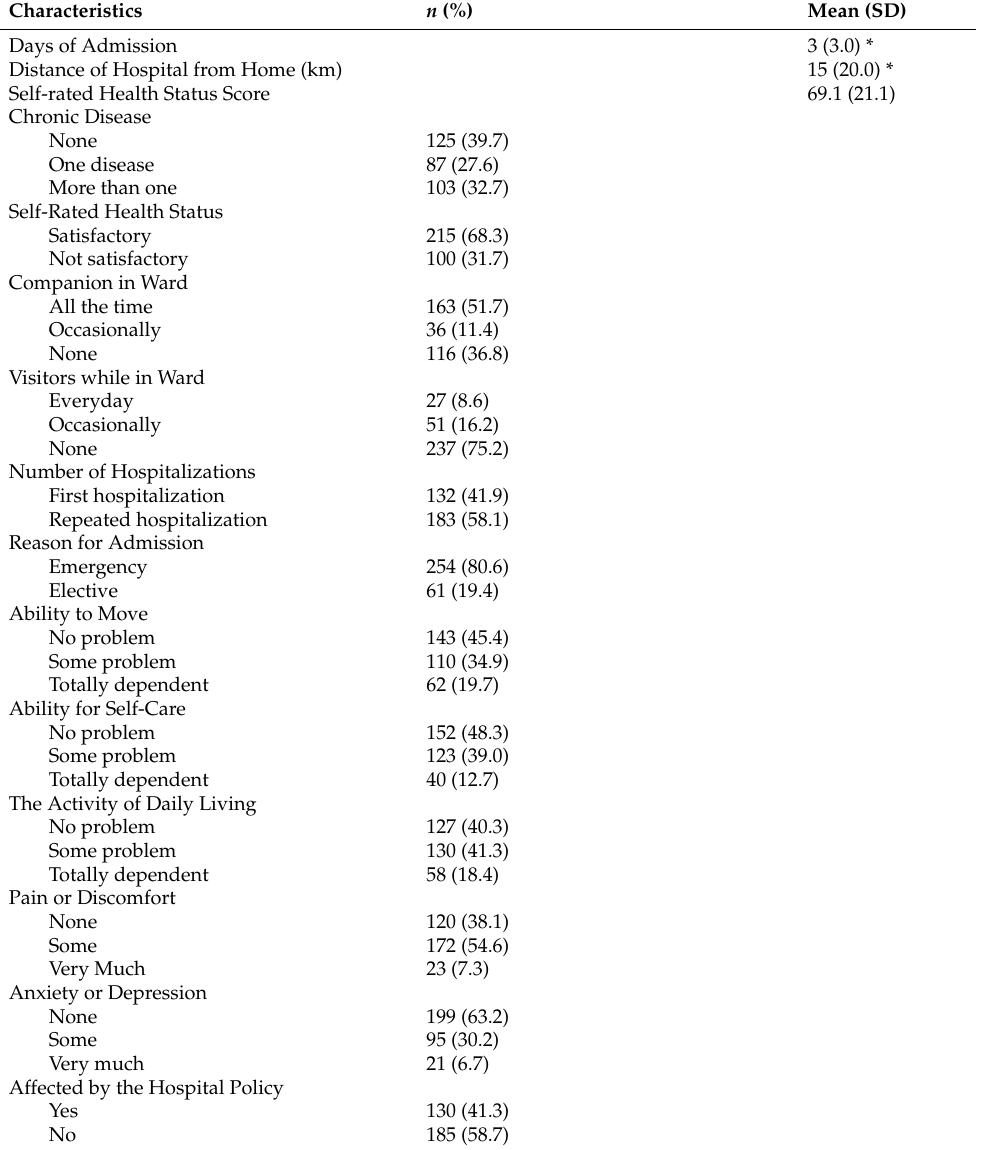
Table 2. Medical, support, and current admission background ( n =